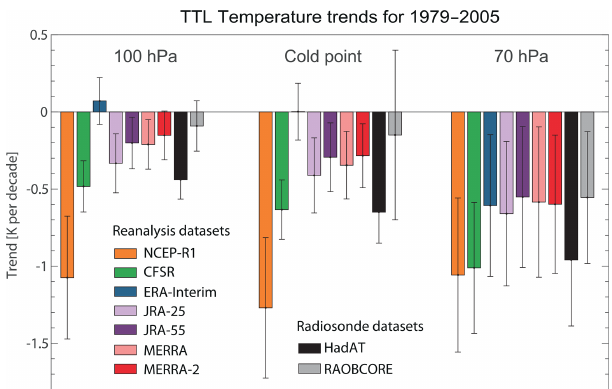
Figure 11. Linear trends in tropical mean (20 ◦ S–20 ◦ N) tempera- ture (K per decade) at 100hPa, the cold point, and 70hPa for the time period 1979–2005. Error bars indicate ± 2 σ uncertainty in the trend and account for serial